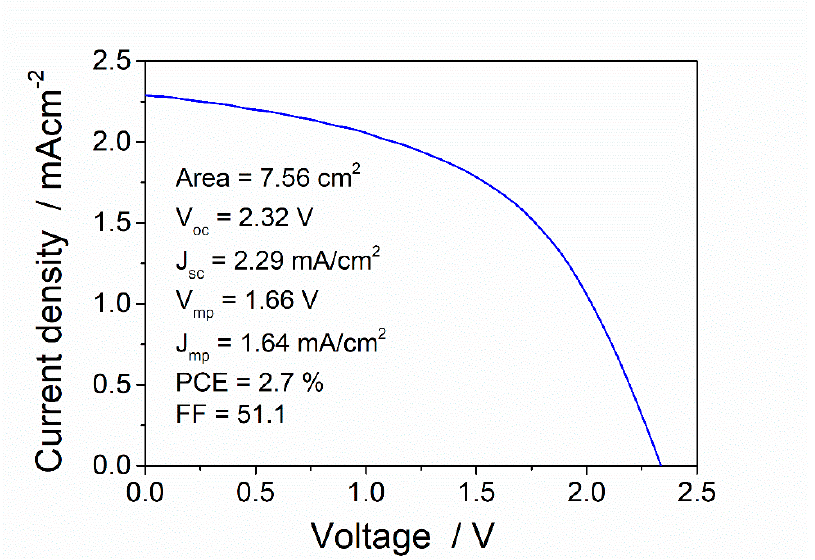
Figure 4. Electrical characterization of a single stripe from an Infinity-PV foil organic solar panel under AM 1.5 solar irradiation.